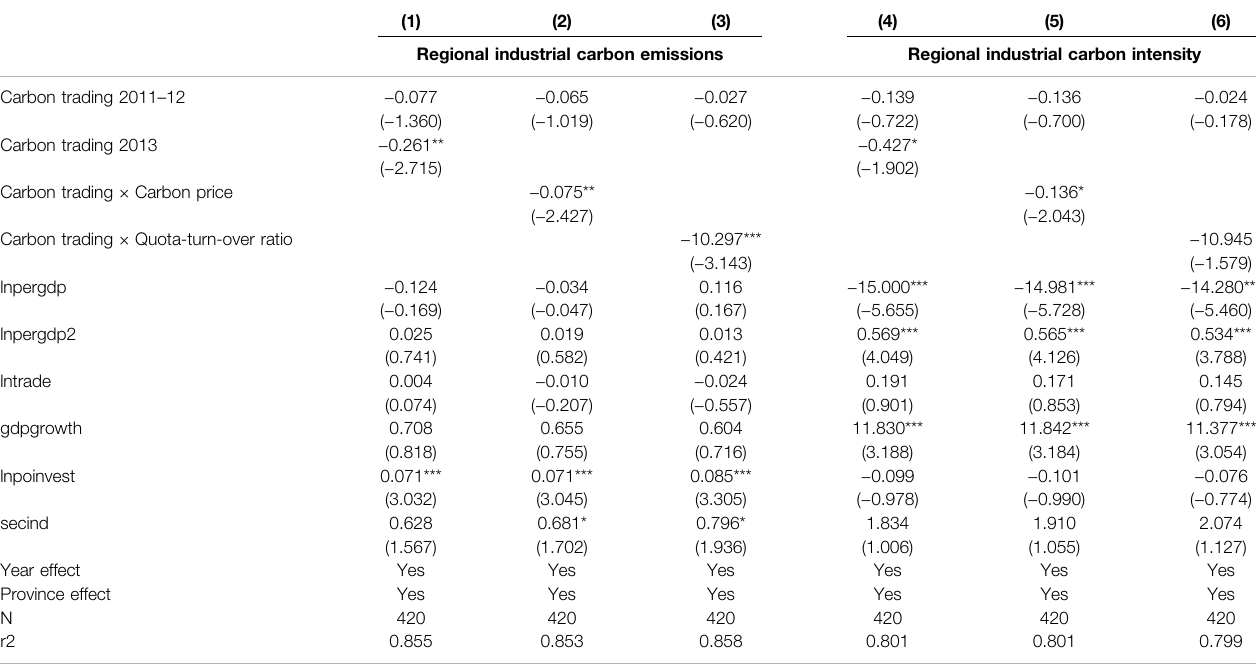
TABLE 3 | Impact of carbon emissions trading on regional industrial emissions at different stages.